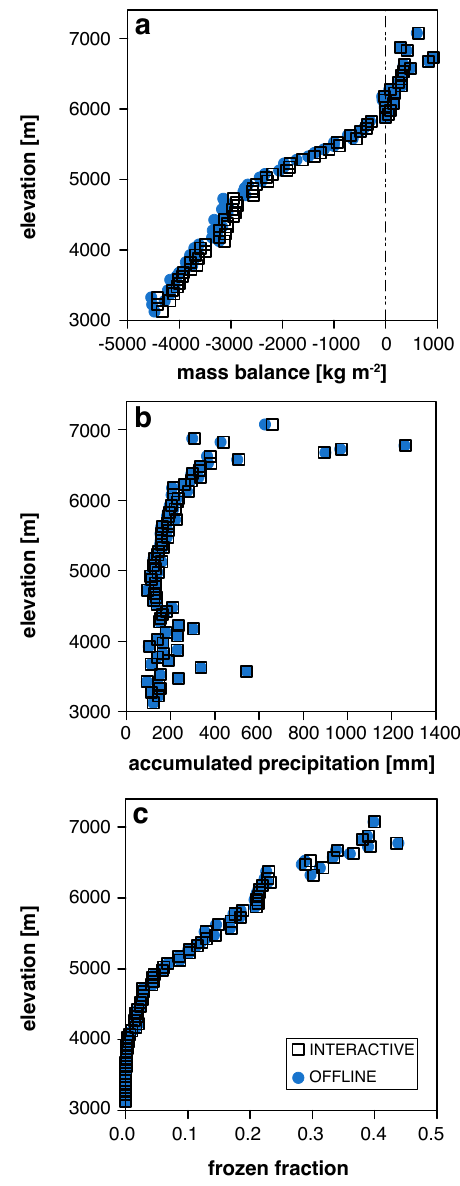
Fig. 8. (a) The vertical mass balance profile of the Karakoram basin at the end of the simulation. The altitudinal dependence of (b) total accumulated precipitation, and (c) mean frozen fraction, averaged over the simulation. Data are area-averaged in 50m elevation